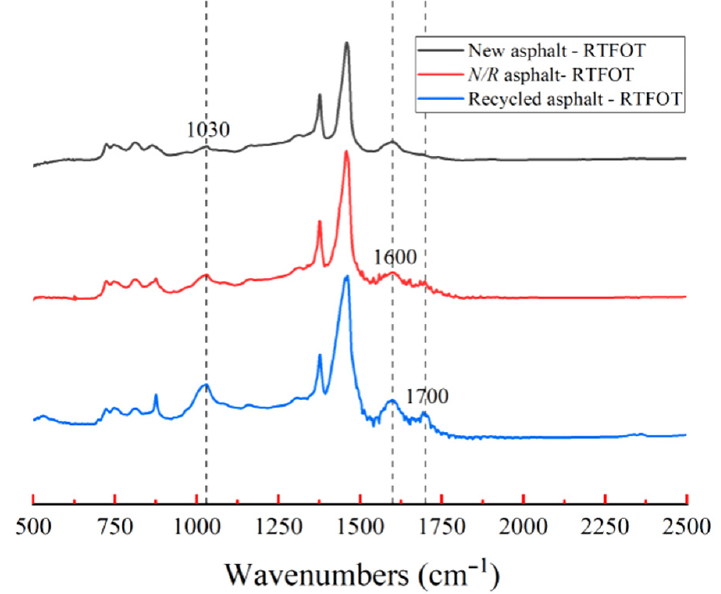
Figure 3. Infrared spectra of three asphalts after RTFOT aging.